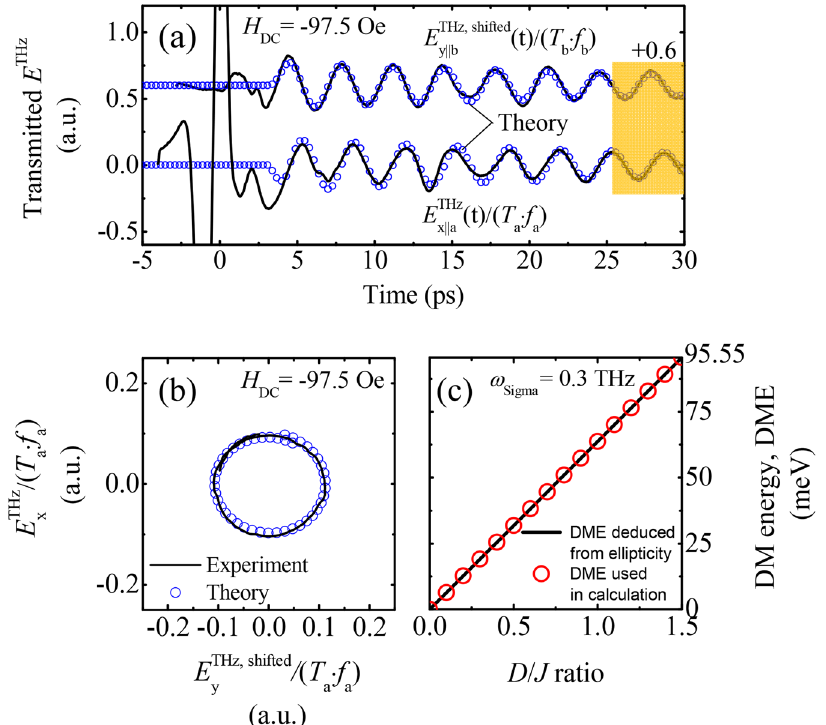
bTHz,shifted is the Figure 6. THz emissions scaling linearly with the spin wave trajectories and simulations. ( a ) E y bTHz because of the refractive index difference, Δ n = − 0.23, temporal waveform shifted by − 1.15 ps from E ab y aTHz and E bTHz,shifted were considered by different between the a and b axes at 0.3 THz. In addition, the resultant E x y transmissions, T a = 0.41 and T b = 0.35, and phase mismatching factors, f a = 0.99 and f b = 0.84, which results from the interference between propagating THz pulses and emissions. ( b ) Two-dimensional trajectories of emissions in the temporal window between 25 ps to 30 ps. In ( a , b ), the experimental results (solid line) are matched closely to the numerical ones (open circles) calculated by using the parameters extracted from the sample. ( c ) The determination of the various DM energies when the S-mode is weakly excited or a Gaussian- type magnetic pulse with [ H 0 , σ t , α ] = [1 Oe, 1 ps, 0] is applied. The DM energy used in the simulation (open circle) is comparable to one deduced from the ellipticity (solid